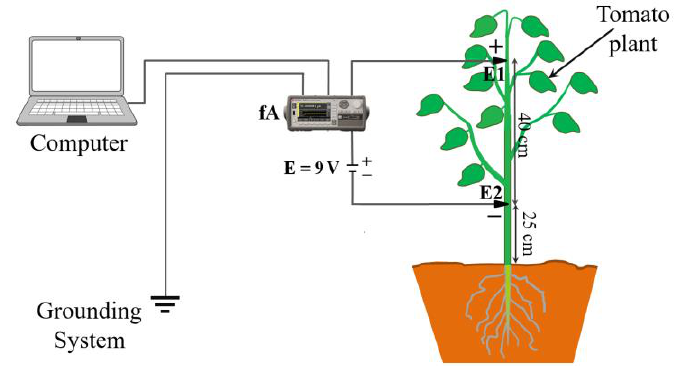
Figure 1. The electrical scheme used to monitor the electrical signal generated by the flow of nutrients through the xylem of tomato